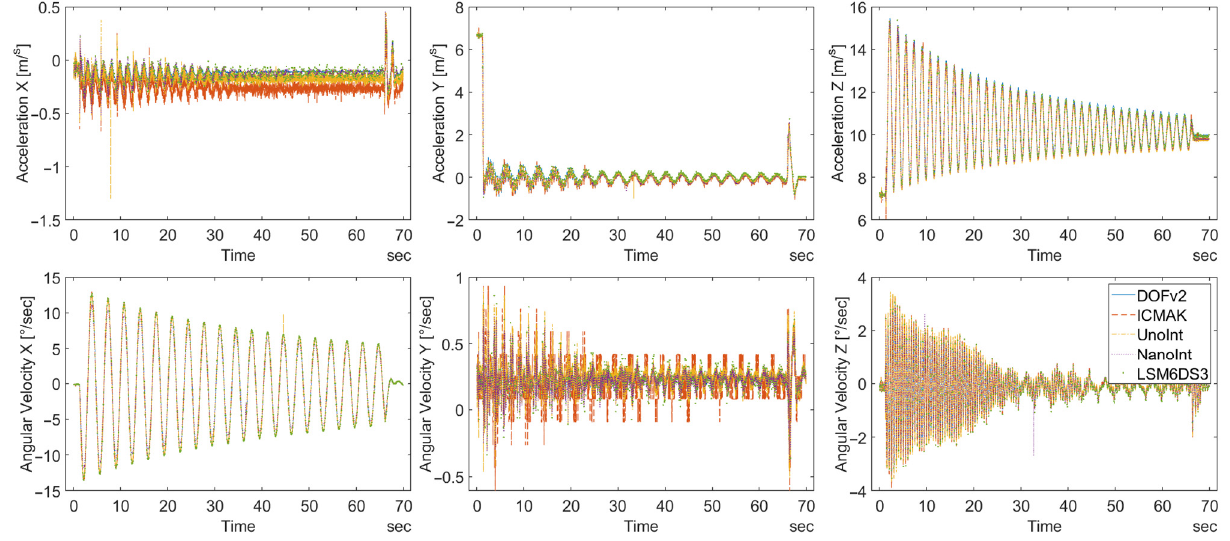
Figure 14. Raw accelerometer and gyroscope data in all three axes, measured using the DIY sensors. The charts in the upper row of Figure 14 display raw data for acceleration. The directions of the axes correspond to the coordinate system displayed in the lower right part of Figure 15b. As expected, the largest amplitudes are found for the z -axis, while on the other two axes, the acceleration values are considerably lower, but not negligible. The gyroscope data were measured simultaneously with the acceleration data. As expected, the maximum amplitude of the angular velocity was found for the rotation along the x -axis.